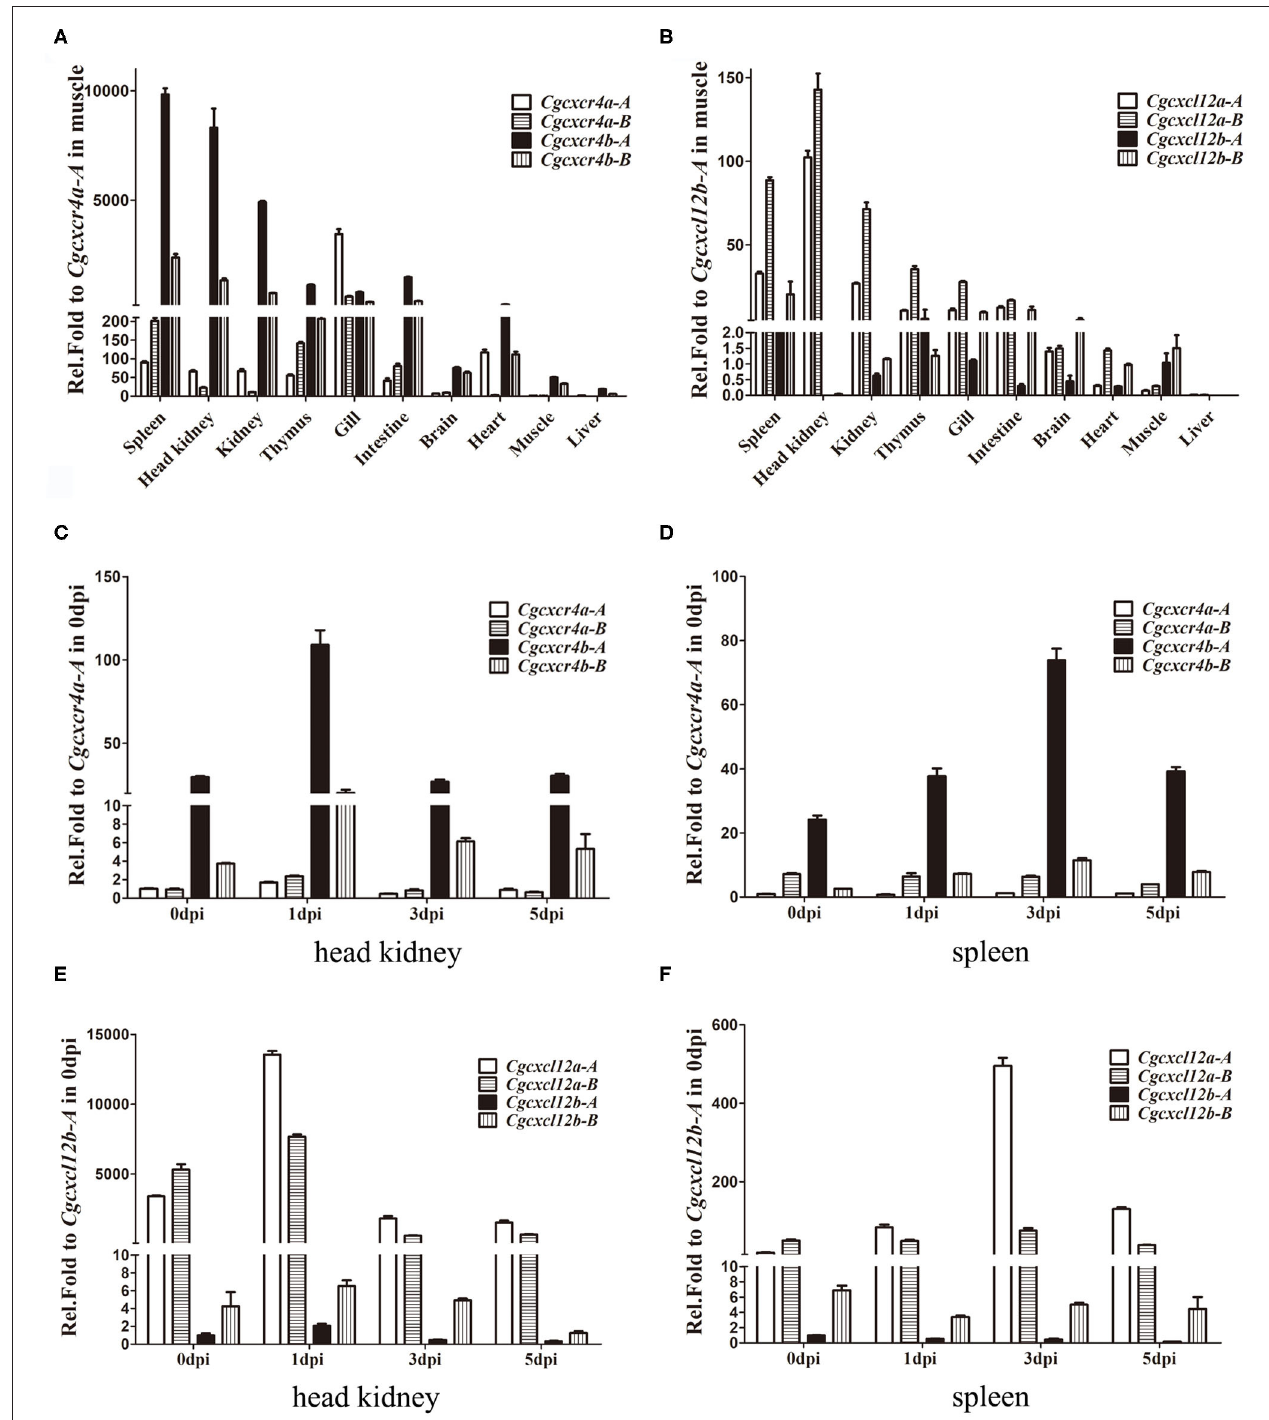
FIGURE 3 | Differential expression patterns of cxcr4 and cxcl12 genes. (A,B) The expression of cxcr4 (A) and cxcl12 (B) in adult tissues. (C–F) The dynamic expression of cxcr4 / cxcl12 in head kidney and spleen after Ca HV infection, cxcr4 in head kidney (C) , in spleen (D) , and cxcl12 in head kidney (E) , in spleen (F) . eef1a1l1 was used as the reference to normalize the templates. Each bar represents the mean ± SEM ( n = 3).